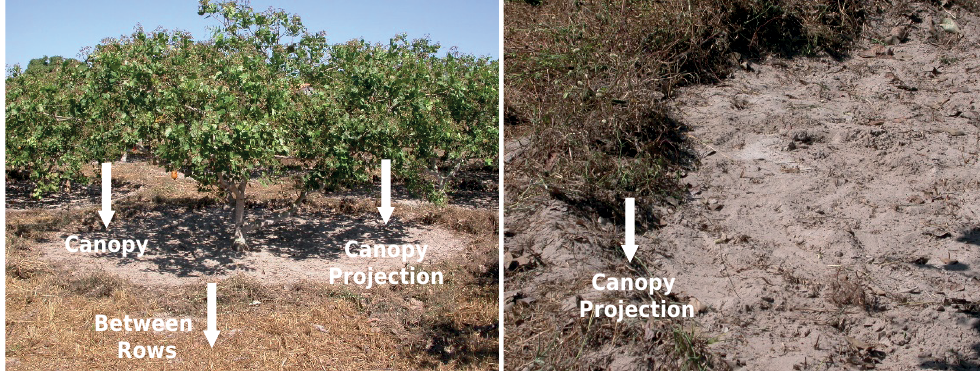
Figure 2. Collection sites of the soil and cashew and spontaneous-plant phytomass in an Arenic Kandiustults cultivated with early dwarf cashew under different management systems in the municipality of Pacajus, Ceará,